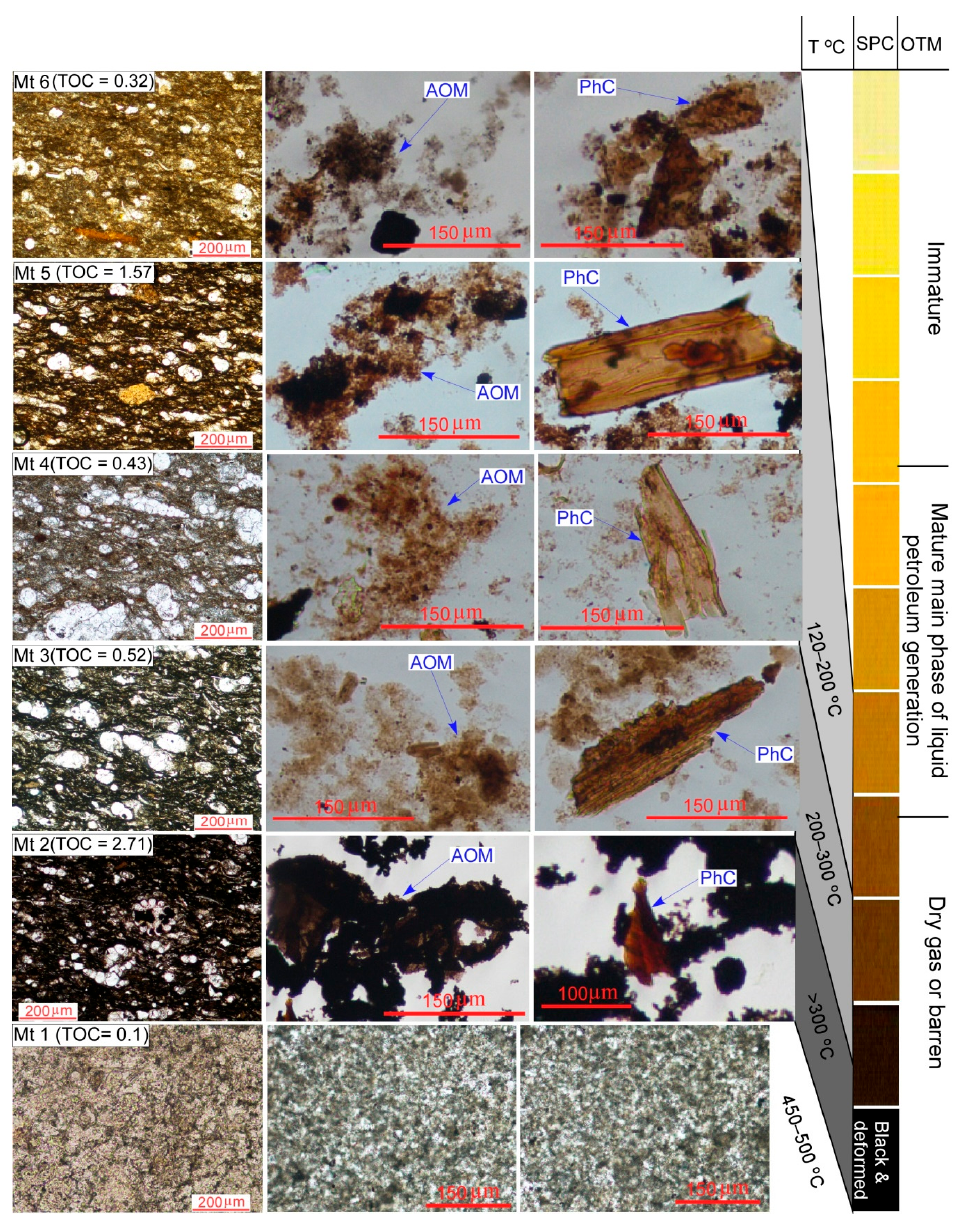
Figure 15. Schematic diagram showing the microfacies coloration, TOC, color of the amorphous organic matter (AOM), and phytoclasts (PhC), separated from the collected samples, in relation to the thermal maturation as compared to the standard Pollen/Spore Color Index (PSCI).